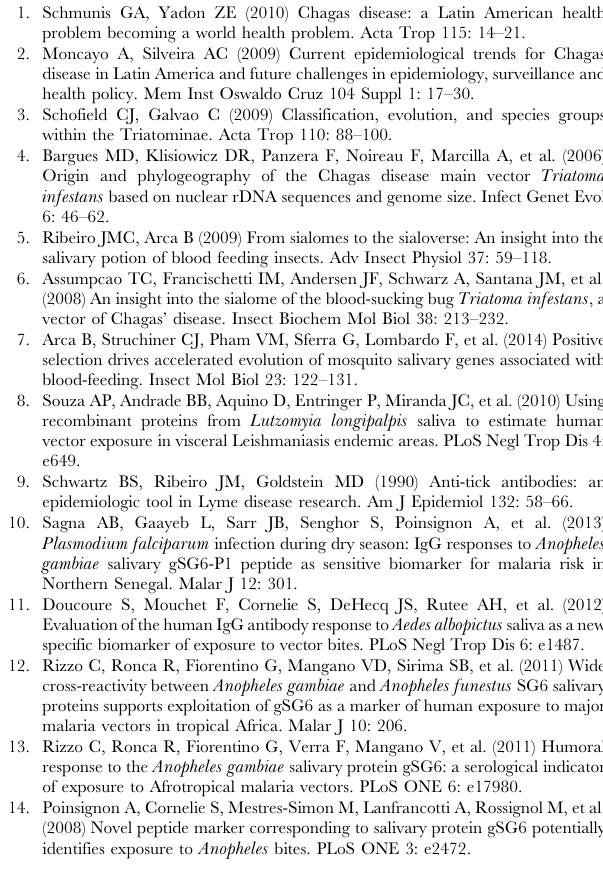
Figure S1 Bootstrapped phylogenetic tree of triatomine lipoca- lins. The sequences discovered in this work are represented by Ti- or TiSigp- followed by the contig number. Other sequences were derived from GenBank and are indicated by the first three letters of their genus name, followed by the first three letters of their species name followed by their gi| accession number. Triatoma infestans sequences found in this study are marked with a red symbol. Those from GenBank are marked with a blue symbol. The tree was built from a ClustalX alignment using the NJ algorithm from the Mega package following 1,000 bootstrap iterations. The numbers at the branches represent the bootstrap percentage support when larger than 50. Table S1 Origin of the T. infestans strains from South America, total SG RNA samples prepared for next generation sequencing and haplotypes obtained for the complete intergenic rDNA region (ITS-1, 5.8S, ITS-2). Table S2 Development times of the different developmental stages of T. infestans and numbers of triatomines used in feeding experiments. File S1 Excel spreadsheet reporting 11,188 coding sequences (CDS) hyperlinked to various databases, and mapped reads and polymorphism from 10 different libraries. This file should be used for sorting on appropriate fields to identify over/under